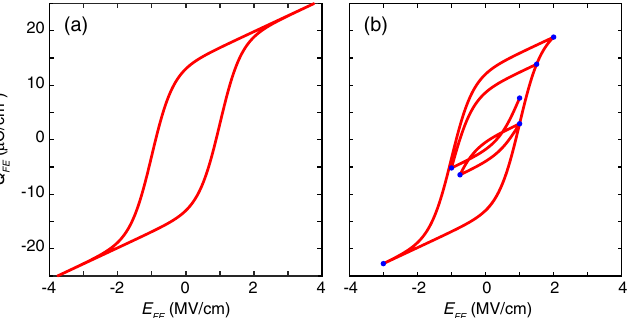
Figure 2. Preisach Model of hysteresis. ( a ) Simulated saturated major hysteresis loop. ( b ) Simulated non- saturated minor hysteresis loops, where the blue dots are the turning points. P s = 14 μC/cm 2 , P r = 13 μC/cm 2 ,